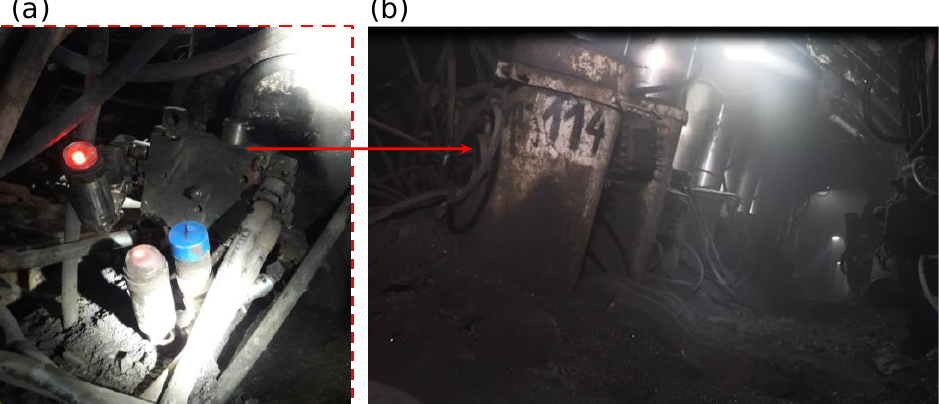
Figure 2. The extraction wall in which the research was carried out, where: ( a ) the measurement system with a prototype double block was installed on a prop; ( b ) view of the section on which the research was carried out.